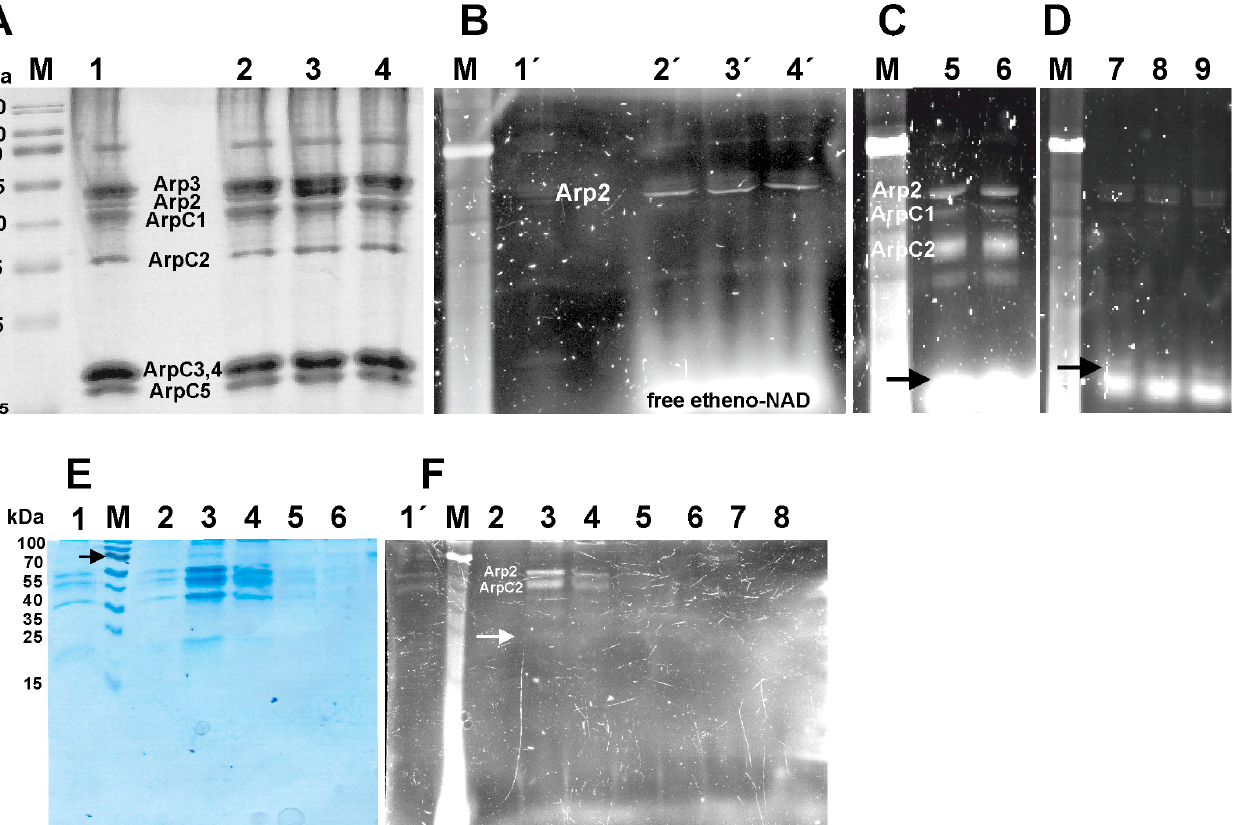
Figure 2. ADP-ribosylation of pig brain Arp2/3 complex by Clostridial toxins using etheno-NAD. Pig brain Arp2/3 complex (20 µ L of 10 µ M) was incubated without lane 1 or with 0.5 µ g of CDTa, C2I, and Iota-a toxin (lane 2 to 4) in the presence of 0.4 mM etheno-NAD. After 2 h at room temperature the reactions were stopped with hot sample buffer and applied to a 15% polyacrylamide gel. The gel was analyzed for fluorescent bands by using a BioRad XR+ system using the “oriole” setting ( B ). Subsequently the gel was stained with Coomassie blue ( A ). The Arp2/3 complex subunits are indicated. Lanes 2 ´ ,3 ´ , and 4 ´ give the fluorescently stained bands corresponding to mammalian Arp2. ( C ) Labelling of pig Arp2/3 by CDTa for 4 h under identical conditions: lane 5 without and lane 6 with 20 µ M VCA-peptide. ( D ) Incubation of pig Arp2/3 with CDTa, C2I, and Iota-a toxin (lane 7 to 9) and 0.1 mM etheno-NAD for 2 h. ( E , F ) Separation of free etheno-NAD from pig Arp2/3 complex (50 µ L of 10 µ M) treated with CDTa for 5 h at 25 ◦ C was subsequently separated from etheno-NAD by gel filtration using a Sephadex G75 column (1.0 × 5 cm). After applying 50 µ L the treated Arp2/3 complex, the column was washed with HEPES-buffer and the following fractions were collected: 0.5 mL in the 1st fraction and thereafter 0.2 mL for fractions 2 to 8. The collected fractions were analyzed by 15% SDS-PAGE with a protein concentration of 2 µ M for the fraction 2 to 4. ( E ) Gives the Coomassie-blue stained gel and ( F ) the corresponding fluorescent image obtained before staining. Lane 1 gives a small amount (about 10 µ L) of labelled Arp2/3 complex before loading to the column and lanes 2–8 the fractions collected; Lane 1 corresponds to first fraction (0.5 mL), thereafter the 0.2 mL fractions. Black arrows in ( C , D ) and also white arrow in ( F ) point to weak labeling of ArpC4,5. Black arrow in ( E ) points to molecular mass marker of 70